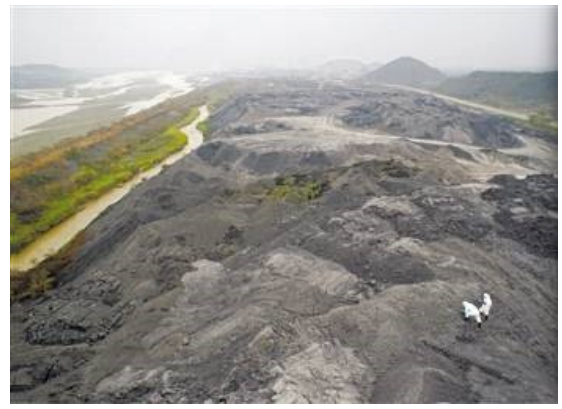
Figure 2. The storage condition of PG in China.